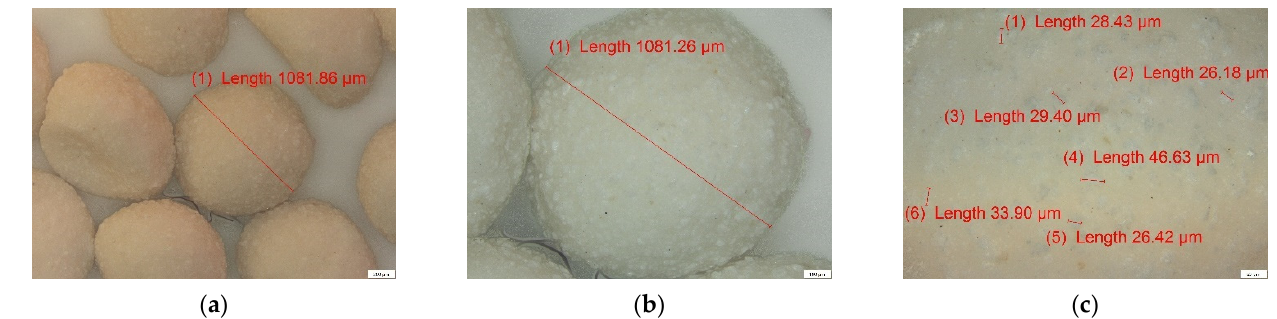
Figure 8. Optical microscopy analysis for ALG–BPA (1:1) microbeads: ( a ) 50×, ( b ) 100×, and ( c ) 200× magnification.